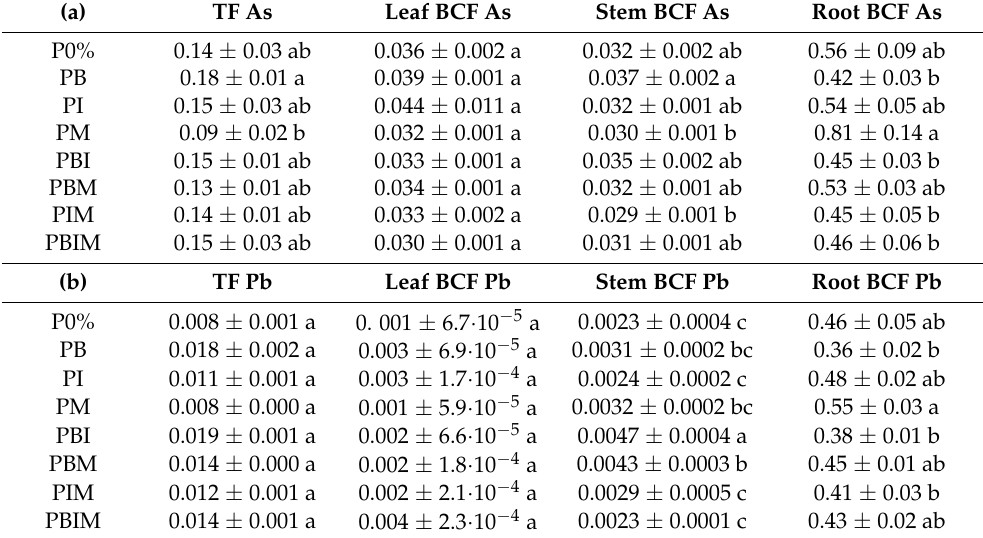
Table 5. Translocation factor (TF) and organ-specific bioconcentration factor (BCF) of arsenic (As) (a) and lead (Pb) (b) calculated for Salix triandra grown for 60 days on the eight studied treatments. For each parameter, different letters indicate significant difference among treatments ( p < 0.05) ( n = 5). The letter “a” is used for the highest value found. Different treatments with at least one letter in common show no significant difference. Thus, different treatments not having any letter in common are significantly different from each